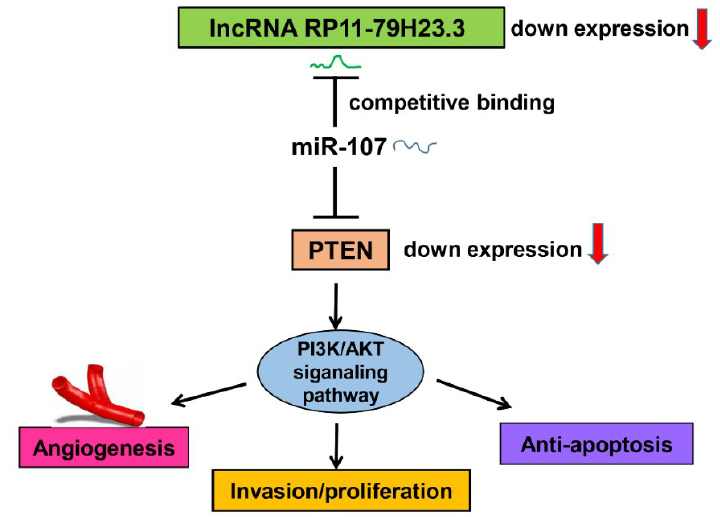
Figure 8. Schematic diagram of the proposed mechanism showing how RP11-79H23.3 as a ceRNA regulates the PTEN/PI3K/AKT pathway in the pathogenesis and development of BC.